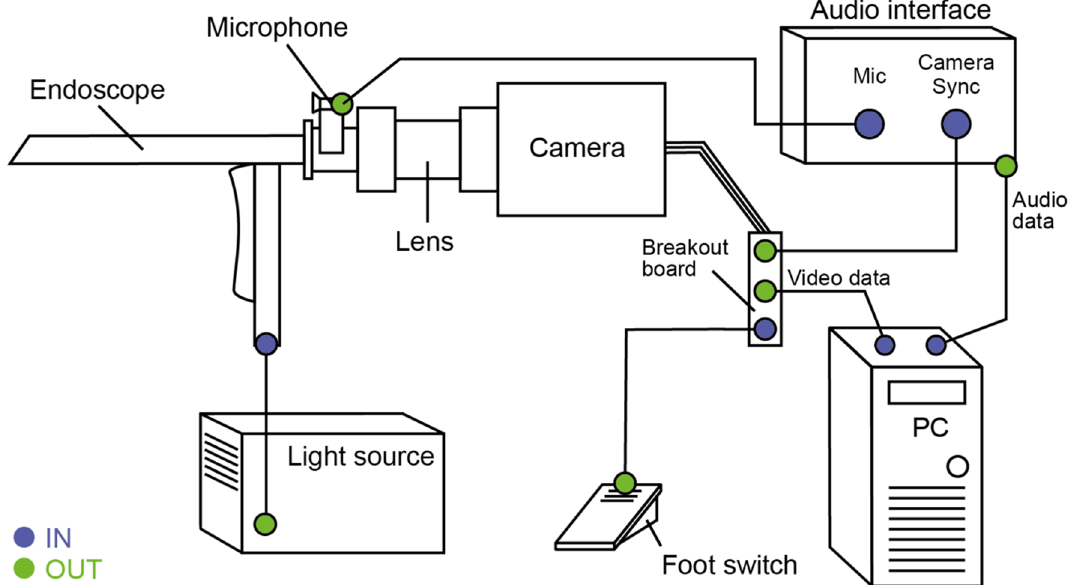
Figure 2. Connection scheme of the OpenHSV system. IN (blue) depicts entry of data, light or signal to a device and OUT (green) the exit of a data, light or signal from a device. The camera sends data to the